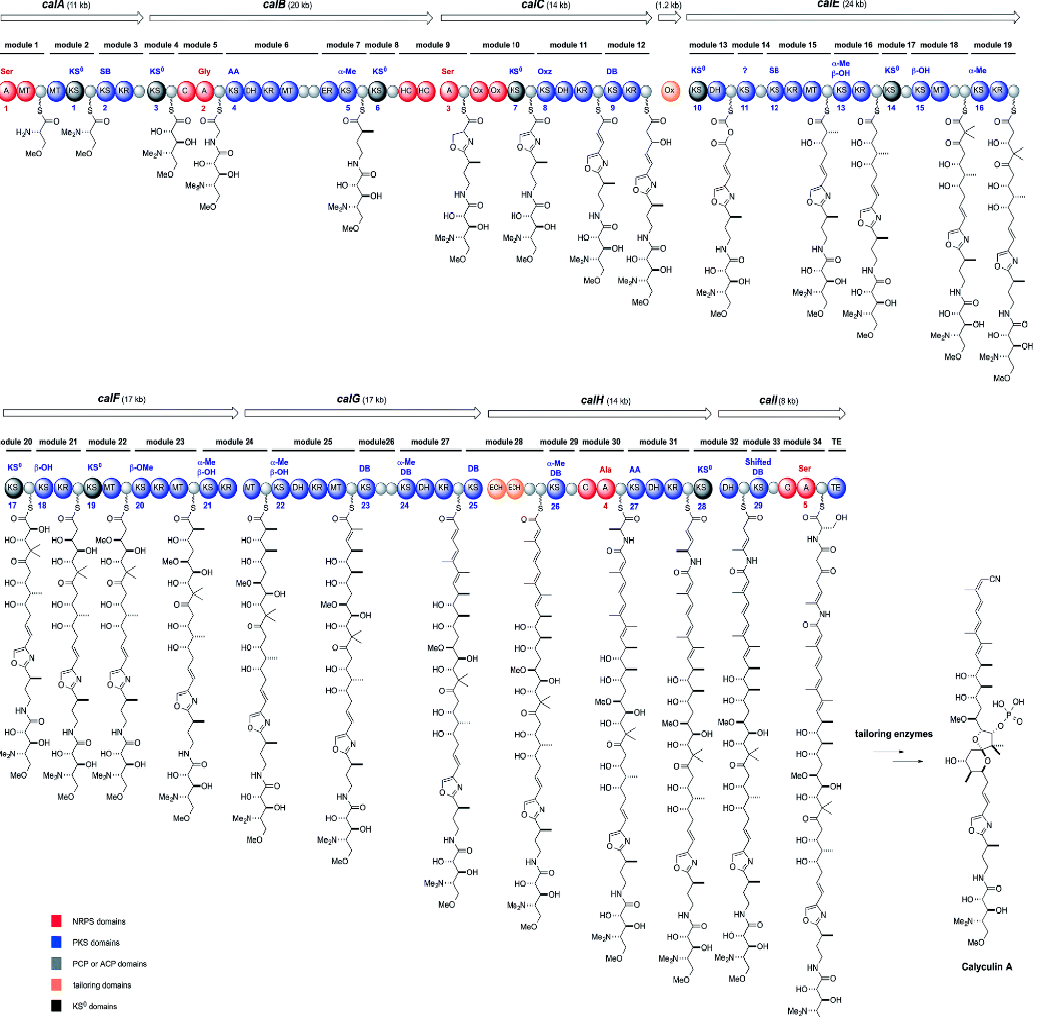
Figure 5. The biosynthetic gene cluster and proposed pathway of calyculin A [214] investigated by Wakimoto, Egami, Nakashima, Wakimoto, Mori, Awakawa, Ito, Kenmoku, Asakawa, Piel, and Abe [115].